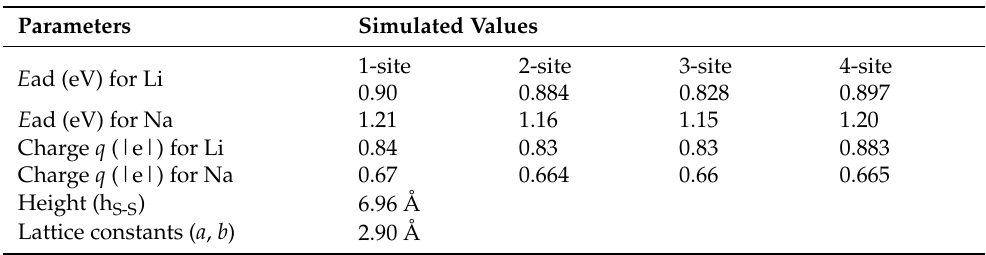
Table 1. Structural parameters of pristine V 4 C 3 M X ene and Li/Na content-loaded V 4 C 3 (2 × 2 × 1 supercell) at x = 0.0625, including binding energy and charge